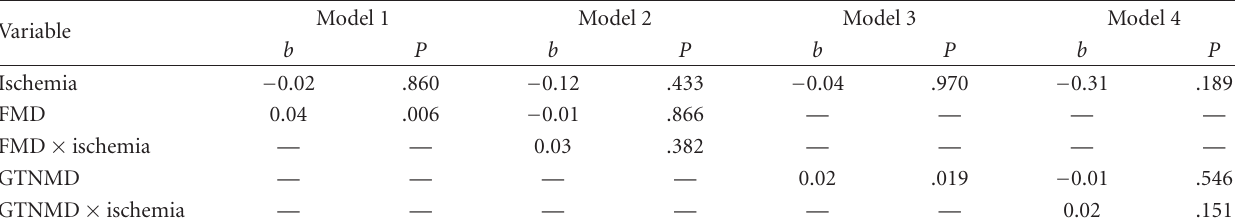
Table 3: Endothelial function variables and ischemia predicting peak oxygen consumption (VO 2 ) during exercise testing, adjusting for vessel size, medication status during the FMD test, age, and